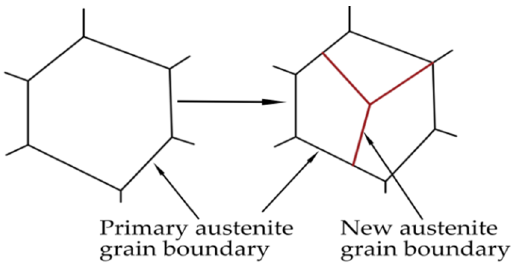
Figure 15. Refining schematic diagram of original austenite in the area of the repair weld joint.